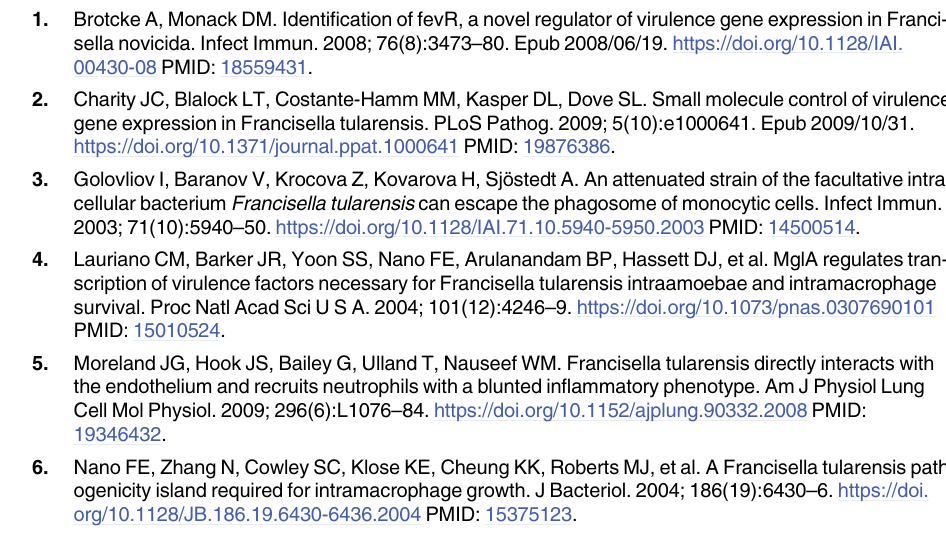
2 - ΔΔ CT method. The error bars represent standard deviations of three independent biological replicates. Asterisks denote that the gene expression of the complemented strain is statistically different from that of the pilO mutant, as determined by Student t- test ( � , p < 0.05). (TIF) S2 Raw Data. The presence of IglC and PdpB in the concentrated supernatants or bacterial pellets of F . novicida , the pilO mutant, the complemented strain pilO/O and iglC mutant grown in the presence or absence of 5% KCl. (TIF) S3 Raw Data. Coomassie staining. The concentrated supernatants or bacterial pellets of F . novicida , the pilO mutant, the complemented strain pilO/O and iglC mutant grown in the pres- ence or absence of 5% KCl were separated using SDS-PAGE and visualized by Coomassie blue staining.